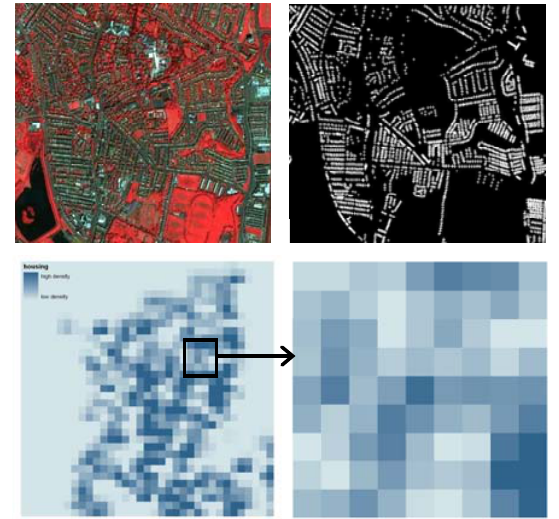
Figure 2: Structural and functional representations of the city of Belfast U.K. IKONOS image (top left), postal addresses (top right), census housing surface (bottom left, for whole of NE Belfast; bottom right, the same spatial dimensions as IKONOS image and postal addresses).